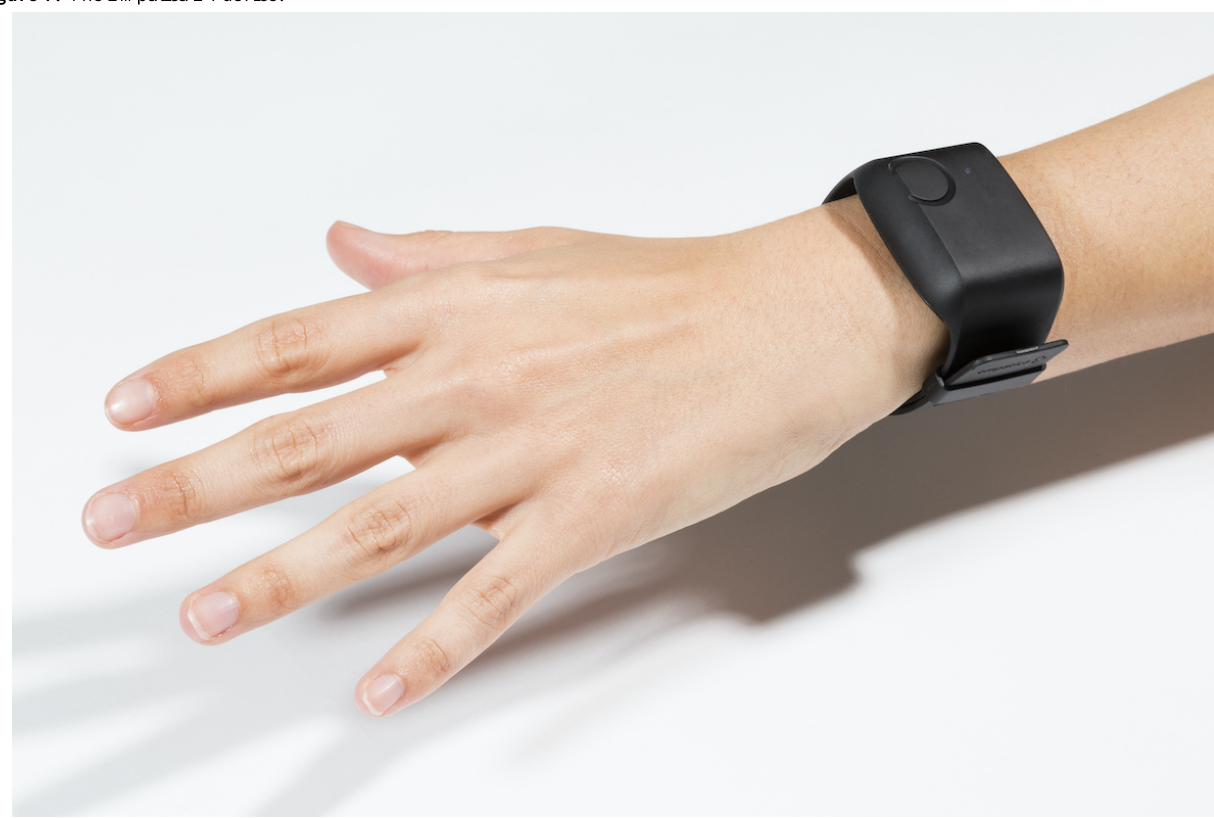
Figure 1. The Empatica E4